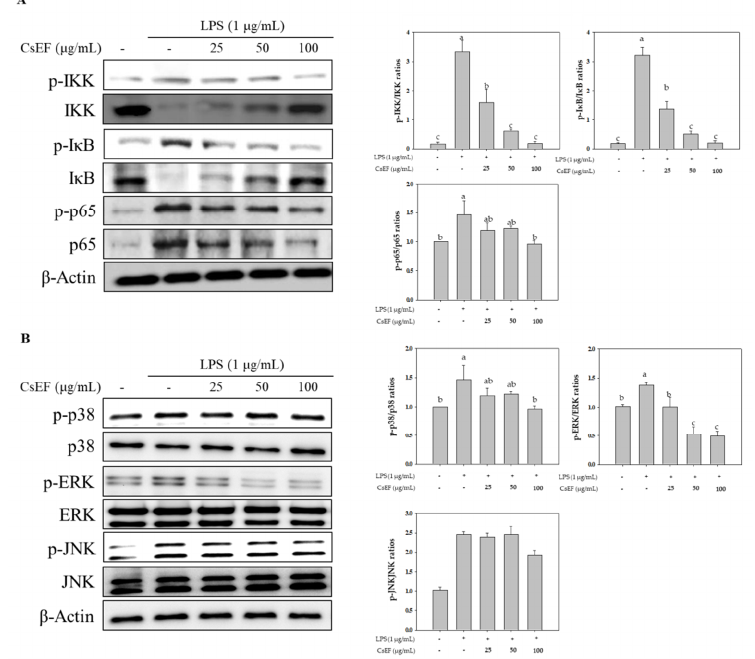
Figure 4. Effect of CsEF inhibits LPS-induced of NF-κB ( A ) and MAPK ( B ) pathway in Raw 264.7 cells. Raw 264.7 cells were pre-incubated with 25–100 μg/mL of CsEF for 1 h and then treated with 1 μg/mL of LPS for 24 h. Total protein extracts were analyzed using SDS-PAGE, followed by im- munoblotting using the indicated antibodies. β-actin served as the internal cytosolic fractions. a–e Means with different superscripts in the same column are significantly different at p < 0.05 .